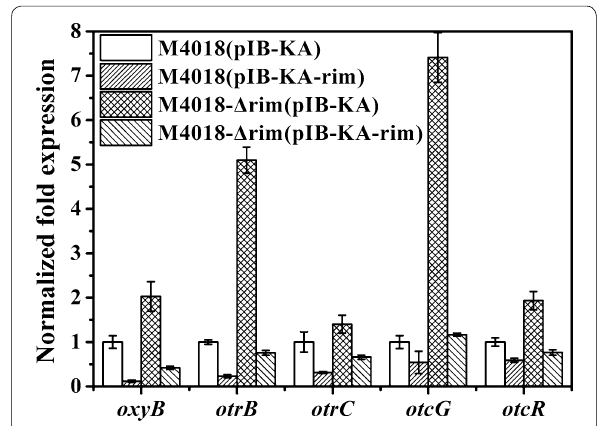
Fig. 7 Evaluation of the transcript levels of five genes oxyB , otrB , otcG , otcR and otrC by qRT-PCR of comparative analysis of the control strain M4018 (pIB-KA) (white square), the mutant strains M4018 (pIB-KA-rim) (square with upper right to lower left fill), M4018 Δrim (pIB-KA) (square with diagonal crosshatch fill) and M4018 Δrim (pIB-KA-rim) (square with upper right to lower left fill) when cultivated on MM with 50 mM gly (96 h). Genes expression in each sample were calculated as the fold expression ratio after normalization to the hrdB transcript as an internal control. The values are averages of three independent qRT-PCR experiments, error bars indicate standard